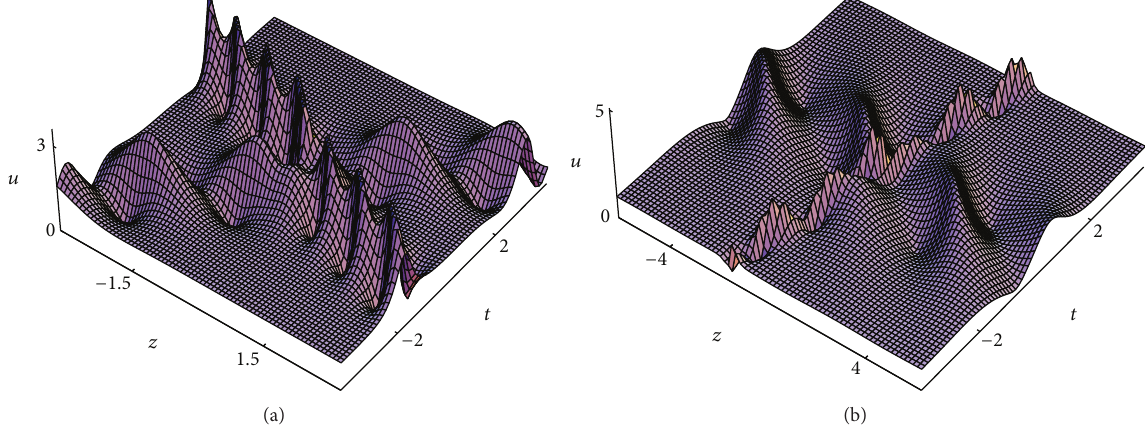
Figure 3: Evolution of the breather solutions of (1). Parameters are (a) 𝑢 𝑐 = 1 , 𝜅 = 0 , 𝜆 1 = 2.05+1.05𝑖 , 𝜆 2 = 2+2𝑖 , 𝛿 = 3 , Γ = 0 and (b) 𝑢 𝑐 = 1 , = 1.5 + 𝑖 , 𝜆 = 3 + 1.1𝑖 , 𝛿 = 3 , Γ = 0 𝜅 = 0 , 𝜆 1 2